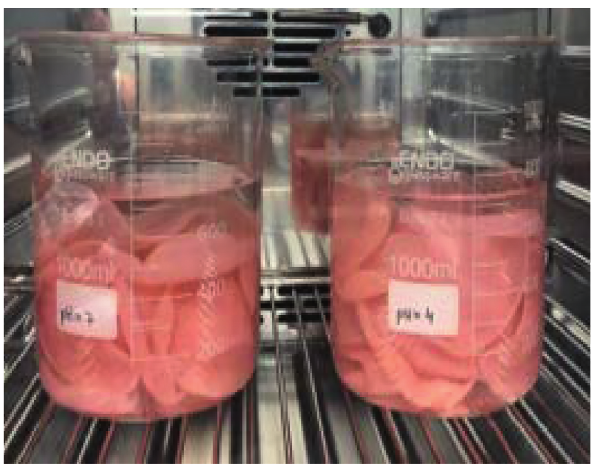
Figure 6: Prosthesis bases subjected to different pH values (pH 4 and pH